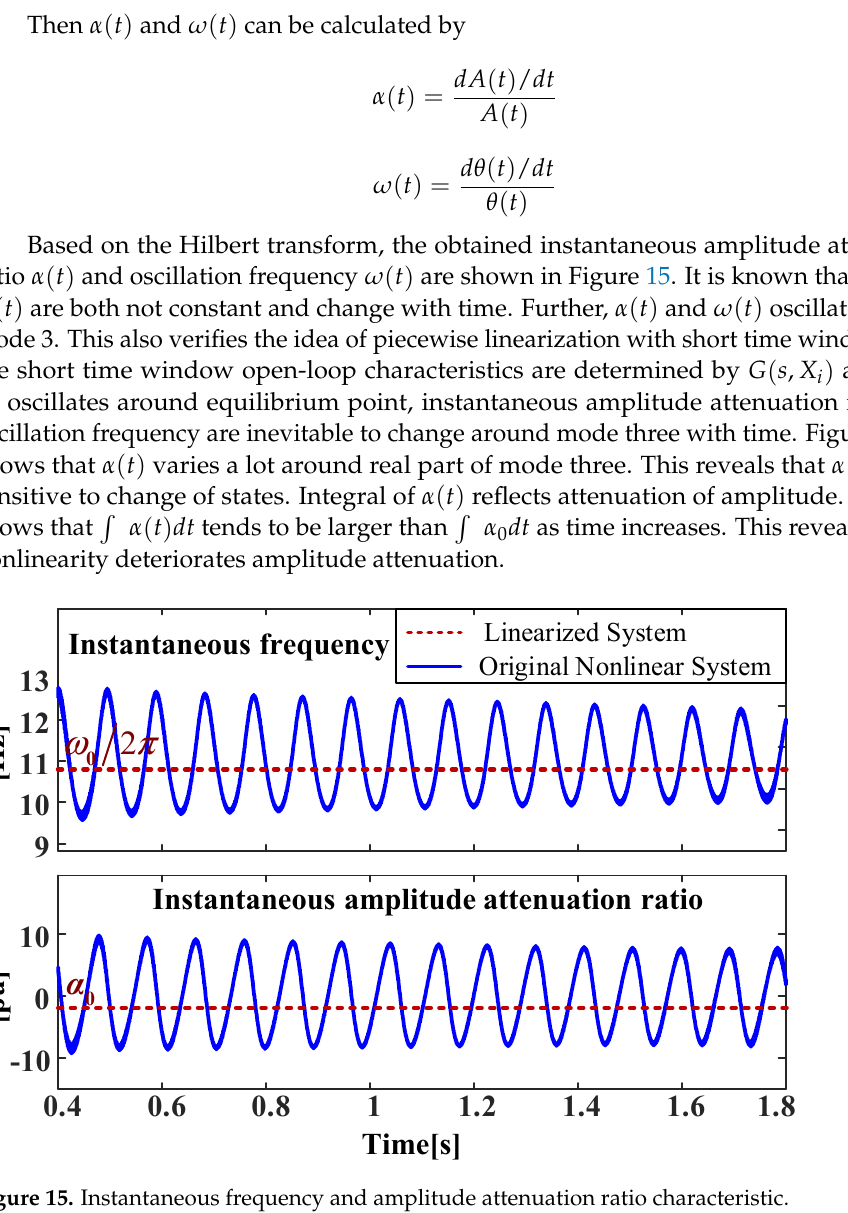
Figure 15. Instantaneous frequency and amplitude attenuation ratio characteristic.